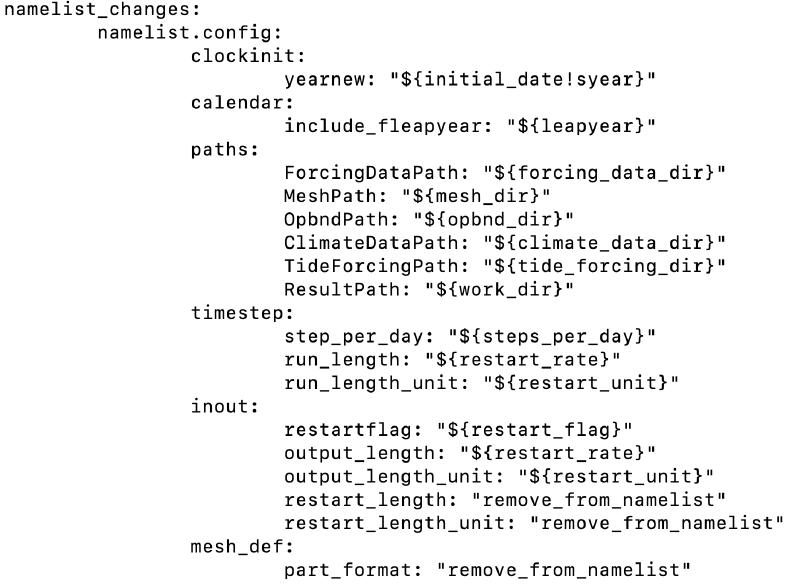
Figure 10. Excerpt from fesom.yaml , specifying how to change the namelist templates during the preparation phase of a